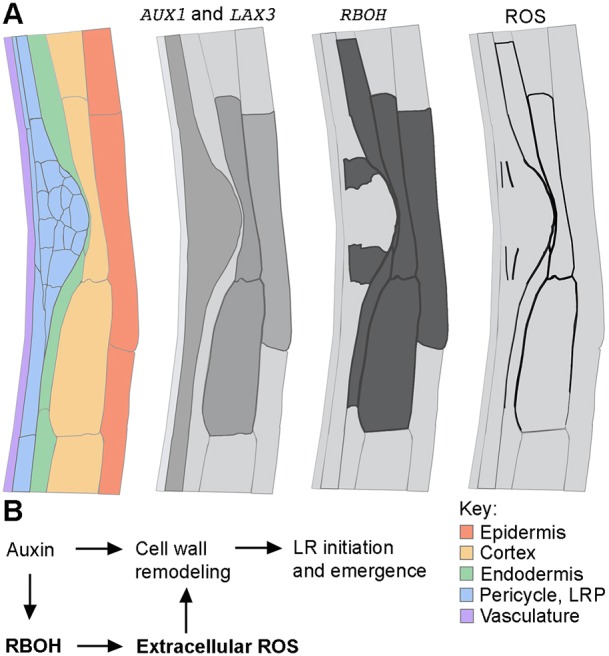
Linking RBOH-mediated ROS production to the current understanding of auxin-mediated LR formation. (A) The expression patterns of RBOH genes overlap with ROS localization and promoter activities of auxin influx carriers during LR emergence (longitudinal section). AUX1 is expressed inside LR primordia and in the pericycle, whereas LAX3 is expressed in the cortex and epidermal cells in front of emerging LR primordia (Swarup et al., 2008; Swarup and Peret, 2012). The promoters of RBOHs are active in peripheral cells of the LRP and in cells surrounding the emerging LRP. ROS accumulates in middle lamella of peripheral cells of the LRP and of cell files overlying the LRP. The vascular localizations are omitted. Schematic representation is based on a TEM tissue section from Fig. 3. (B) Model of auxin- and RBOH-mediated ROS action during LRP emergence. For successful LR initiation and emergence, localized cell wall remodeling in front of LRP is required and relies on an orchestrated operation of several auxin response modules (Swarup et al., 2008). Here, we propose that ROS deposited into the cell walls by the activity of auxin-inducible RBOH enzymes facilitate LRP emergence by promoting cell wall remodeling.